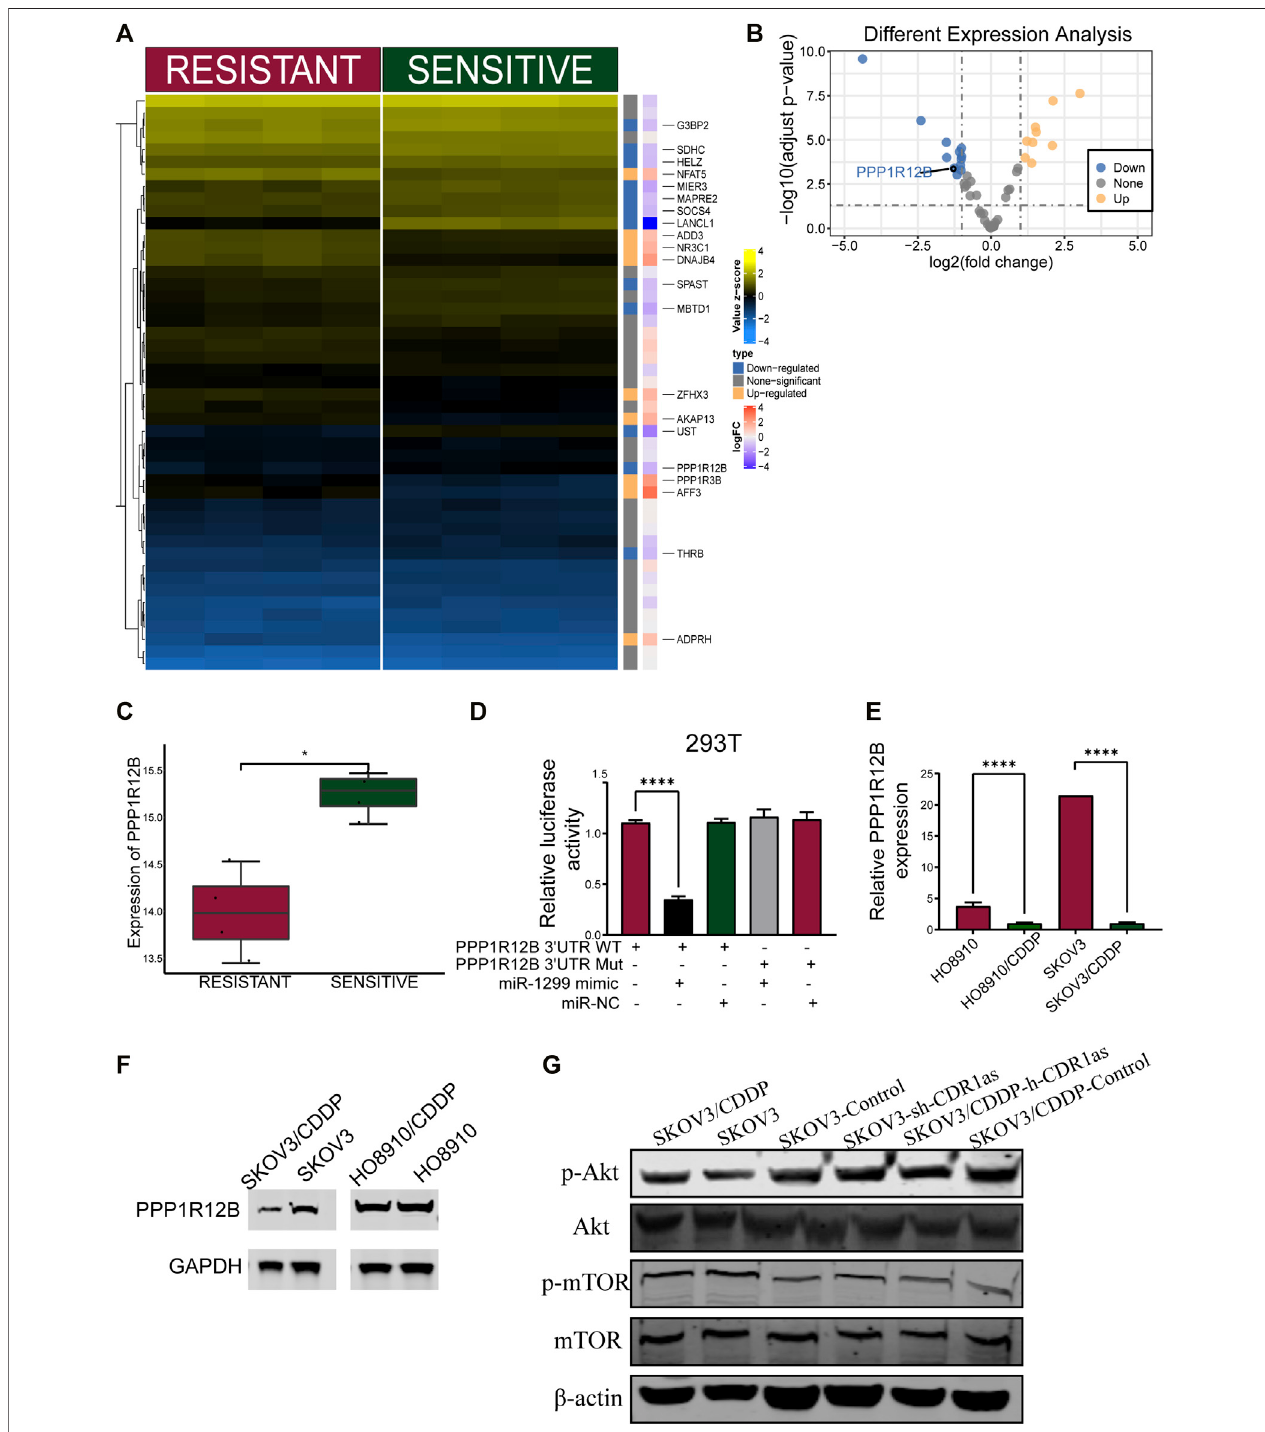
FIGURE 9| PPP1R12B is a direct target ofmiR-1299. (A,B) The heatmap (A) and volcanoplot (B) revealed the mRNAs expression pro fi les in GSE45553. (C) The expression of PPP1R12B in CDDP-resistant and -sensitive cell lines by GSE45553. (D) The interaction between PPP1R12B and miR-1299 in 293T cells was veri fi ed using dual luciferase report assay. (E) PPP1R12B expression in cells lines. (F) The protein expression of PPP1R12B in cell lines by Western blotting. (G) Knockout CDR1as activates Akt/mTOR signaling pathway. These results were presented as the mean ± SDs. * p < 0.05 and **** p < 0.0001.